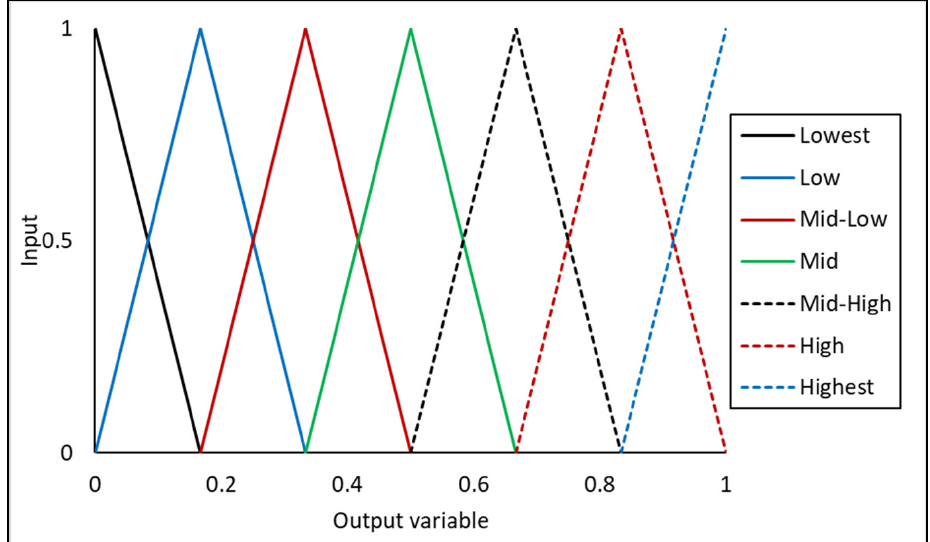
Figure 7. The six output MFs.